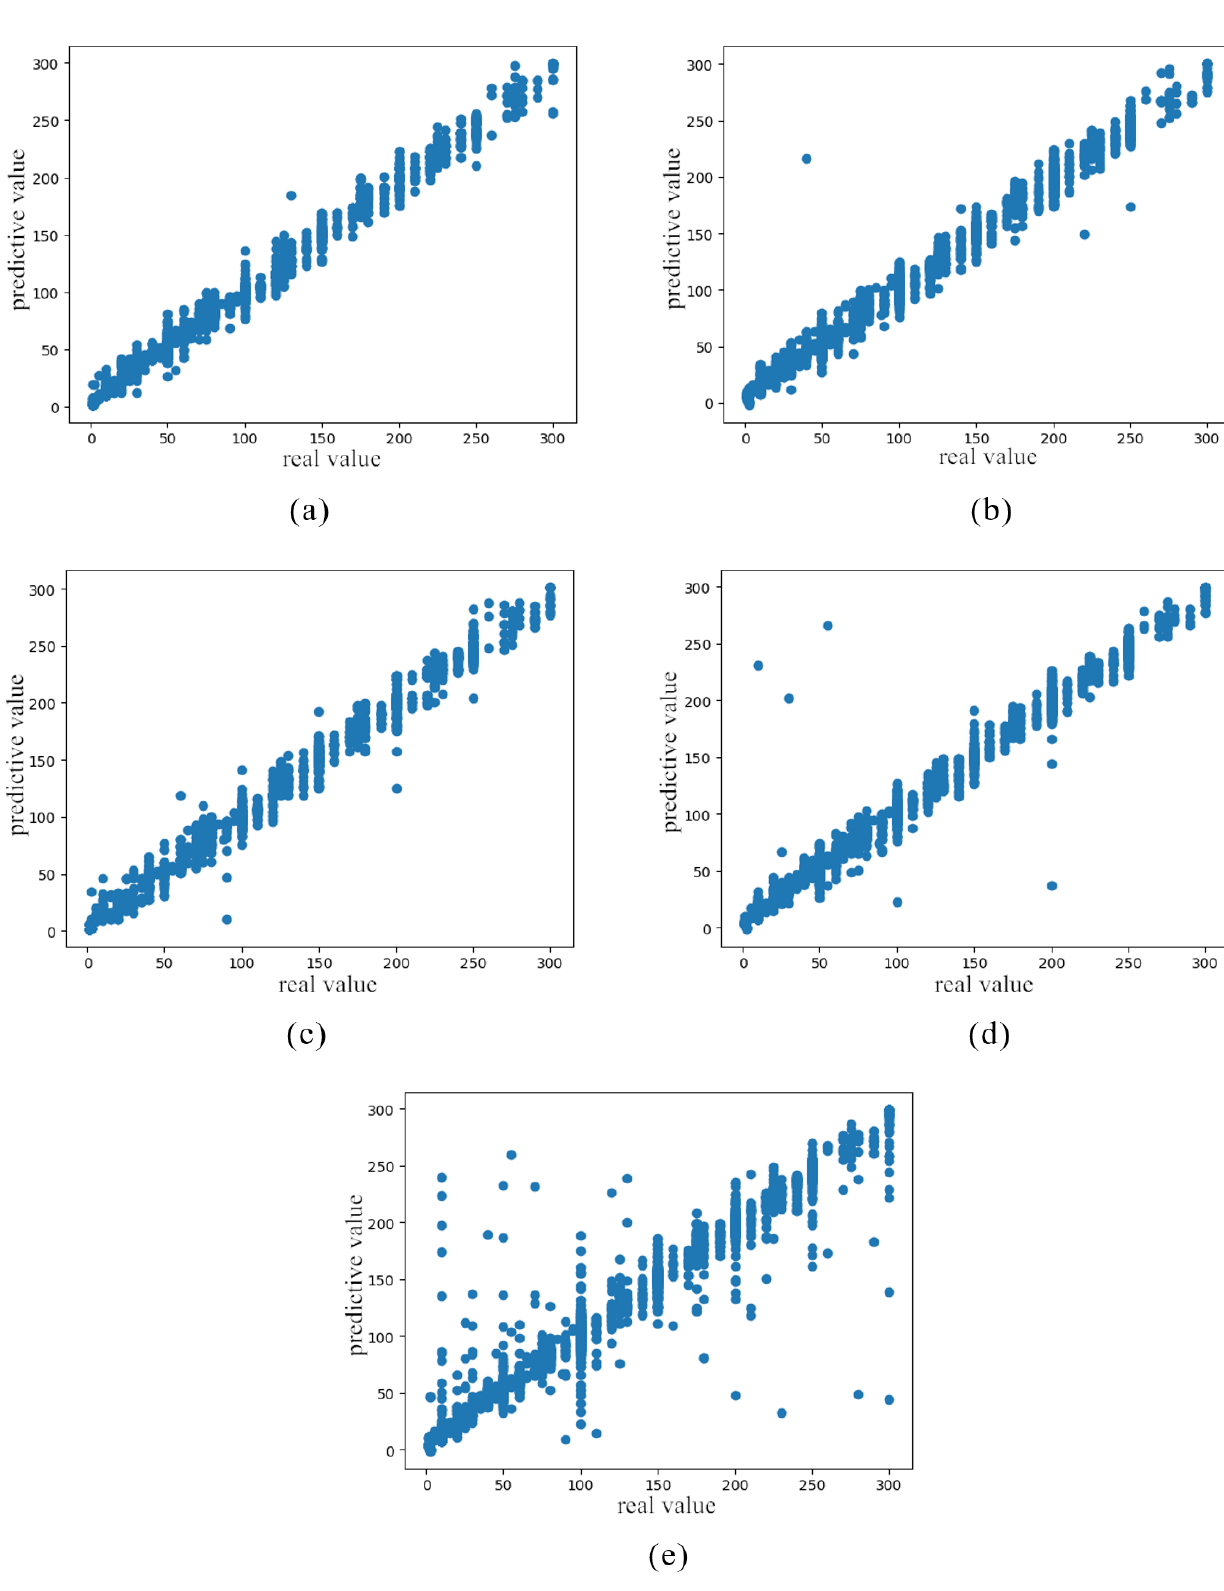
Figure 9. Comparison diagram of fitting algorithms. ( a ) Stacking algorithm prediction result. ( b ) Blending algorithm prediction result. ( c ) Bagging algorithm prediction result. ( d ) Averaging algorithm prediction result. ( e ) SVR algorithm prediction